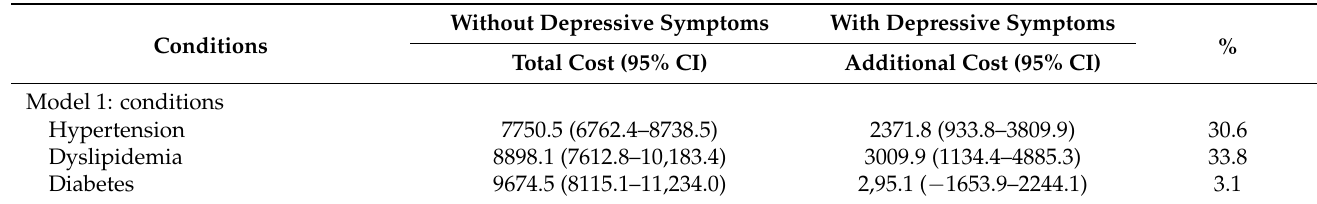
Table A2. Comparing the proportion of health care costs associated with depressive symptoms to total costs of patients without depressive symptoms in 12 common chronic